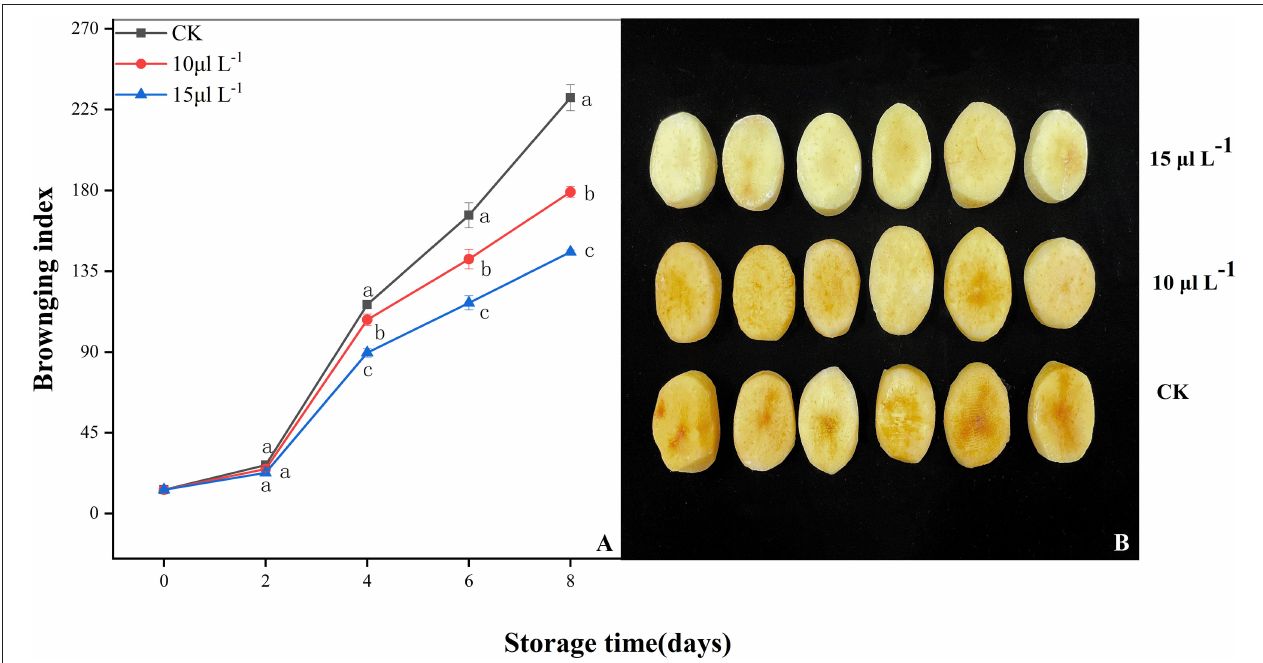
FIGURE 1 | Effects of H 2 S treatment on browning index (A) and photograph (4 days) (B) of fresh-cut Chinese water chestnuts during storage at 10 ◦ C for 8 days. Vertical bars represent the standard errors of the means. Different letters (at the same day) mean that they were significantly different (Duncan’s multiple range test, P <